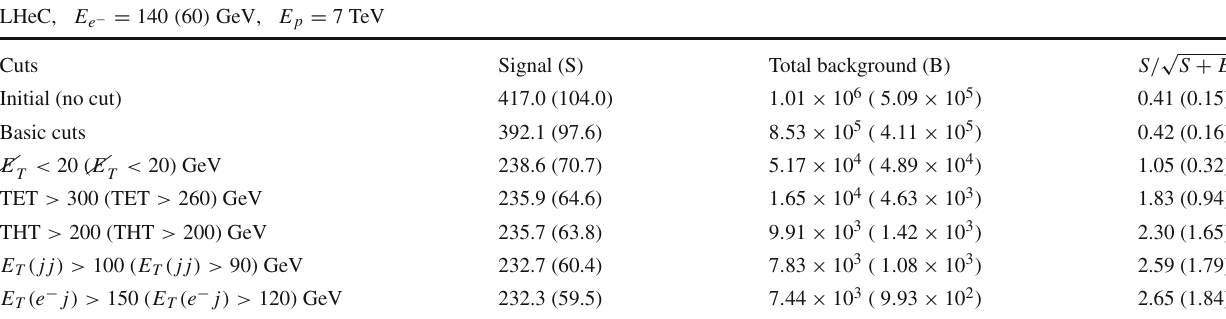
= 300 GeV, M = 0 . 1 GeV, sin α = 0 . 2 and g μτ = 1 × 10 − 3 and the SM Z μτ 2